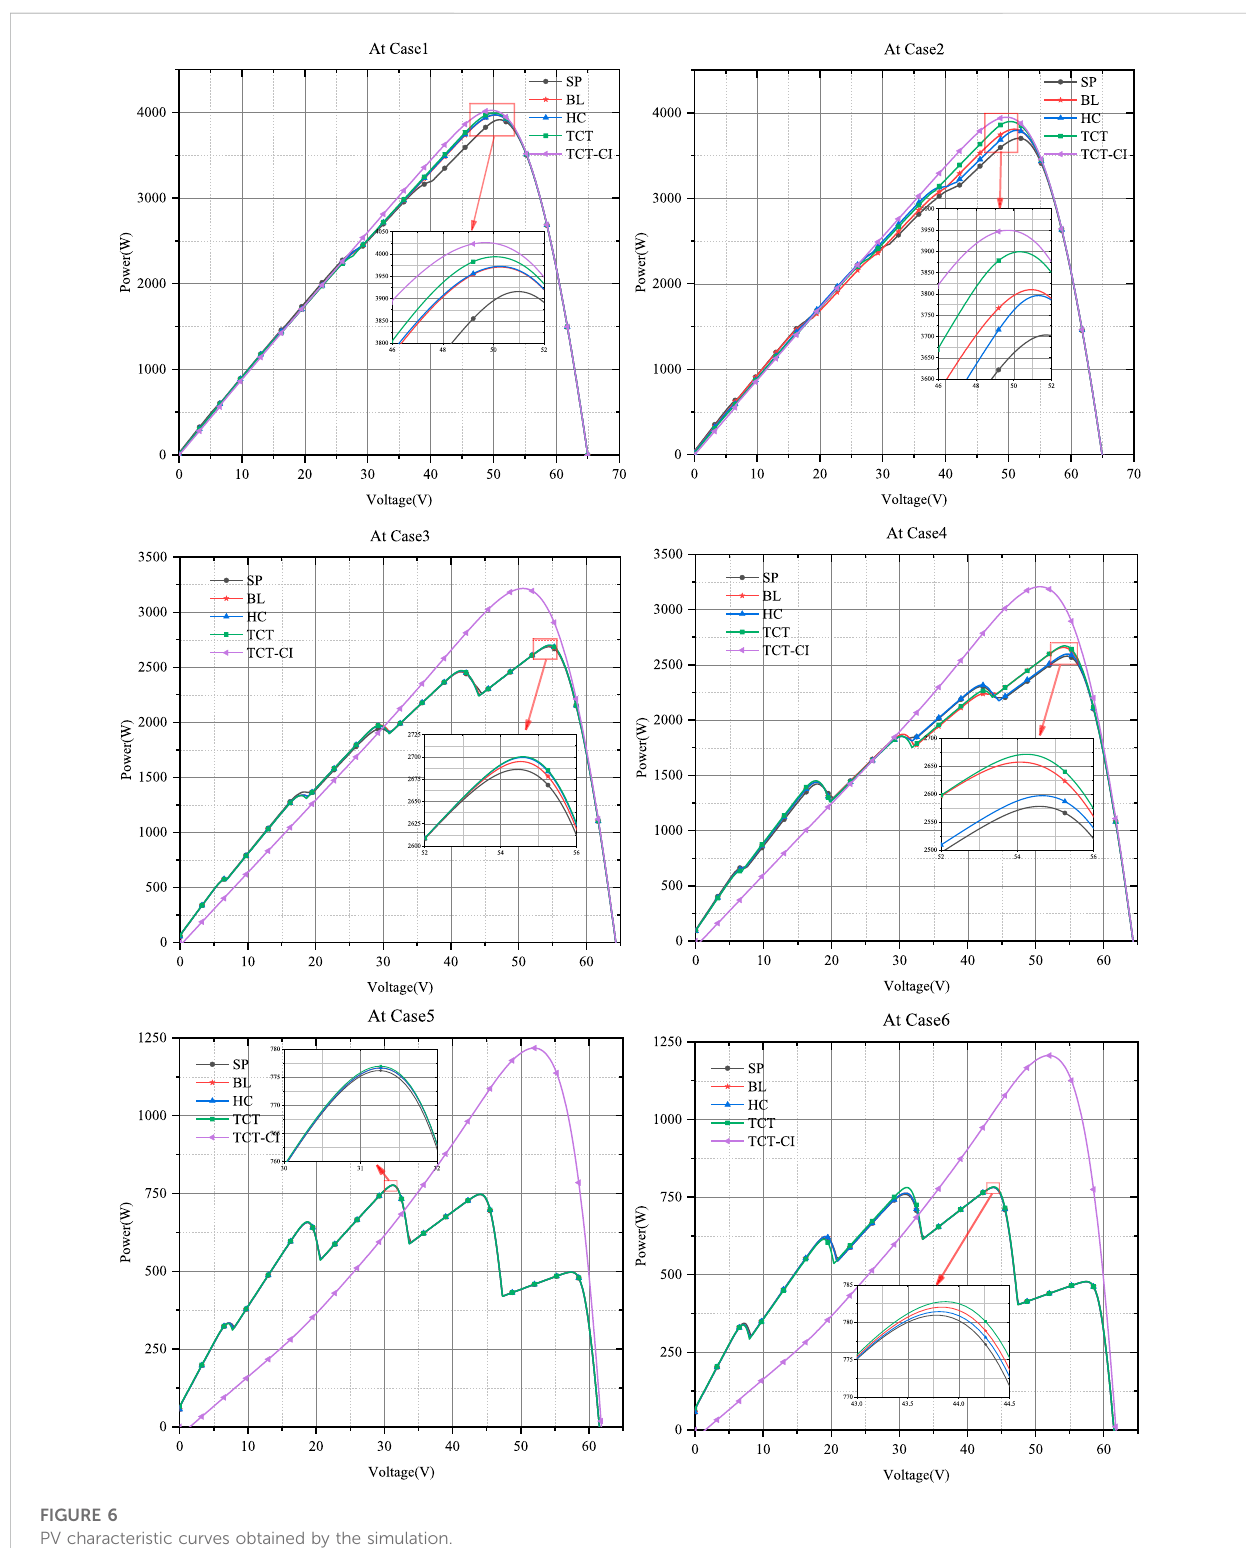
FIGURE 6 PV characteristic curves obtained by the